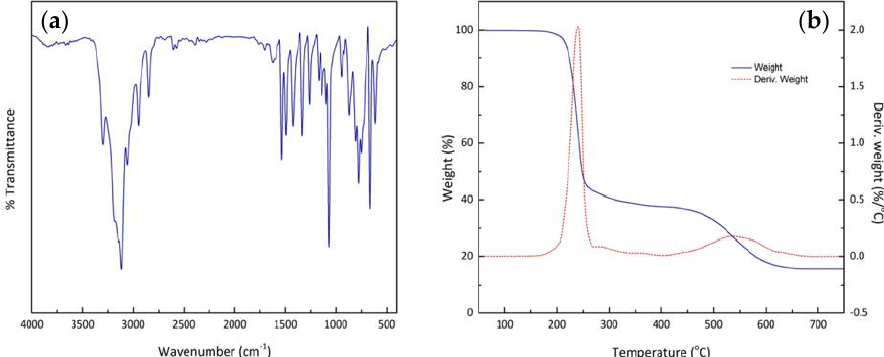
Figure 5. ( a ) FTIR spectra showing functional group characteristic peaks at different wavenumbers, and ( b ) TGA thermogram of Cu(C 3 N 2 H 4 ) 4 Cl 2 coordinate complexes.